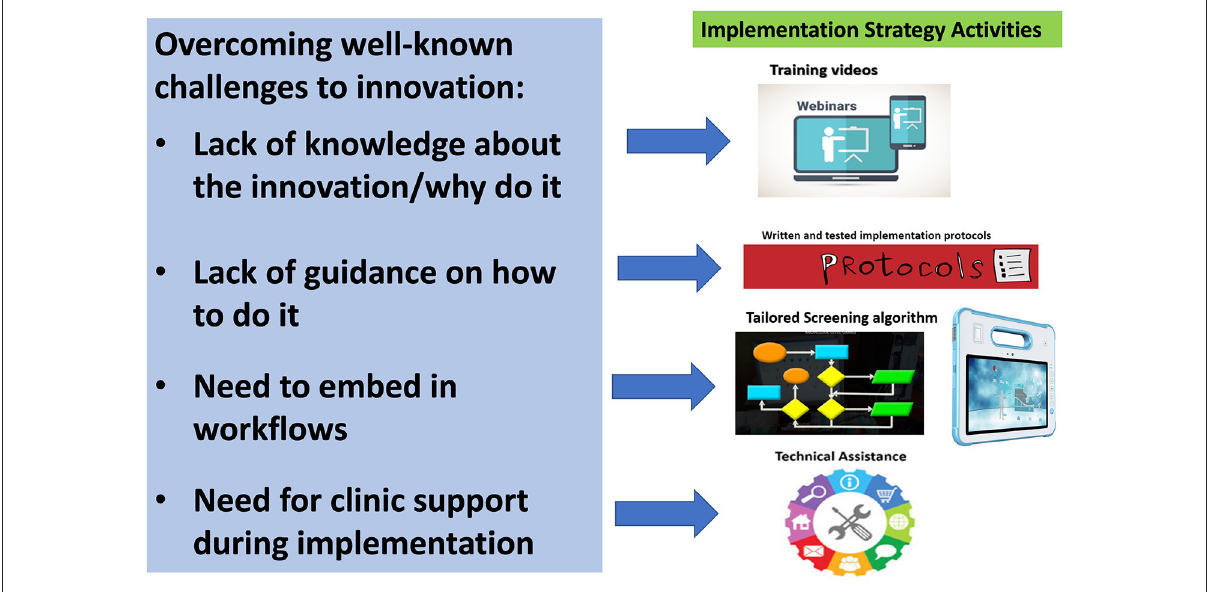
FIGURE1 Template of the implementation strategy activities for ACEs